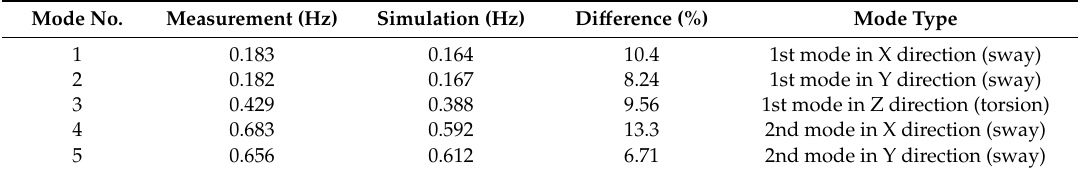
Figure 16. Mode shapes for the first five orders from simulation via finite element method.